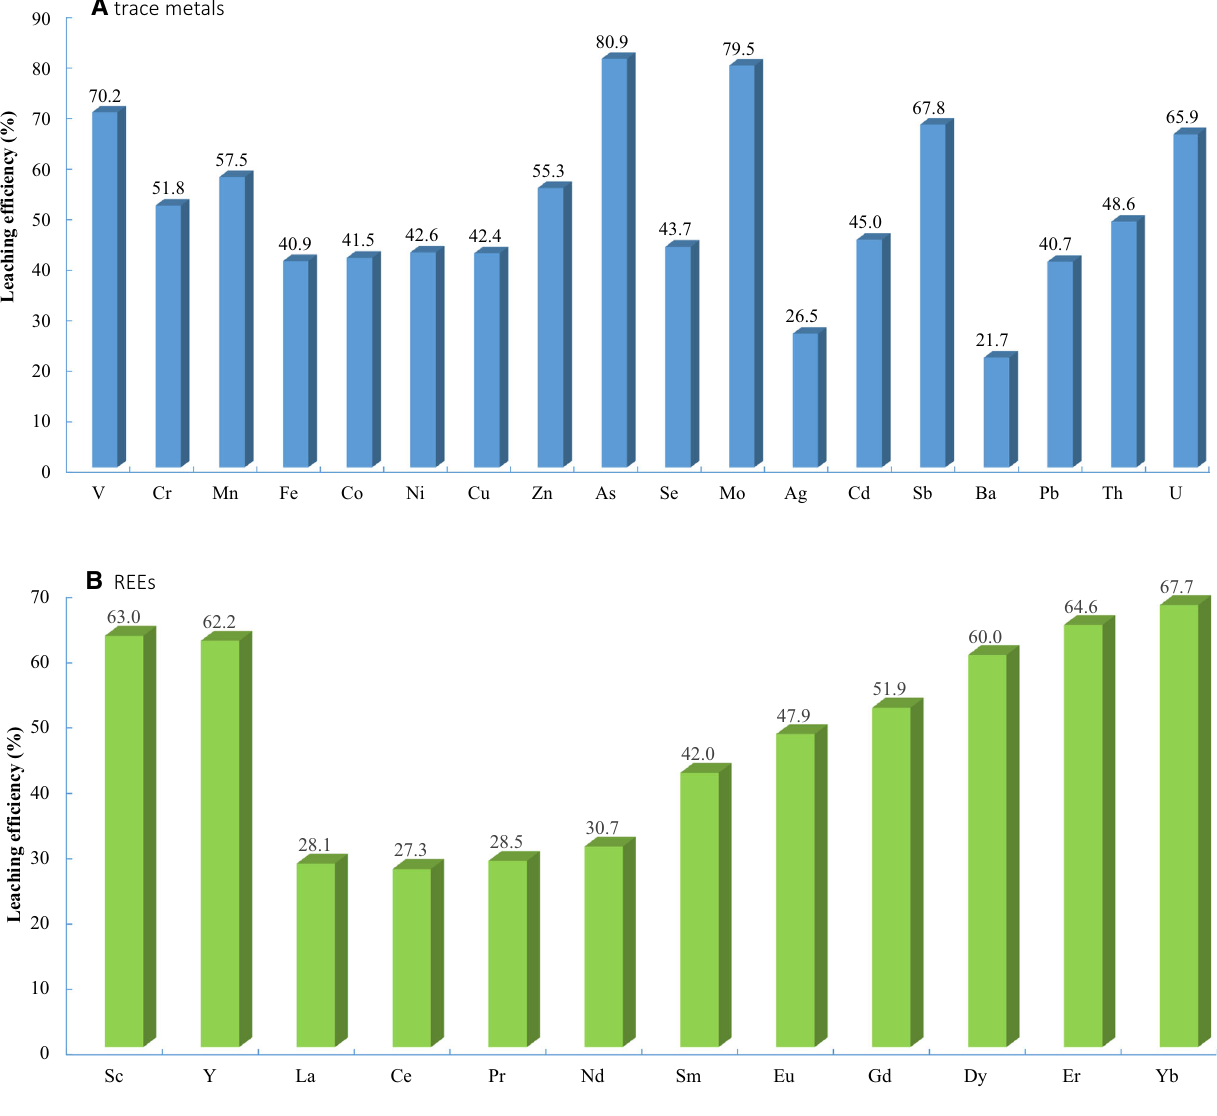
Fig. 3 Leaching efficiency of C. bombicola . a Trace metals; b